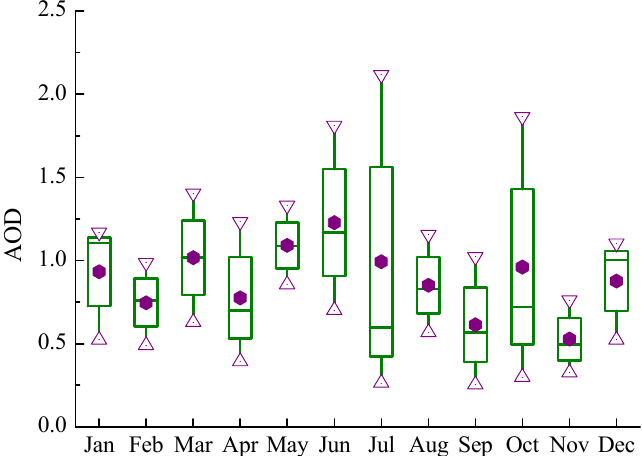
Figure 4. Monthly statistics of AOD at 500 nm. The purple dot represents the AOD mean of the maximum and minimum in each month; the triangles represent the maximum and the minimum of monthly AOD, respectively; the short horizontal line represents the monthly averaged AOD